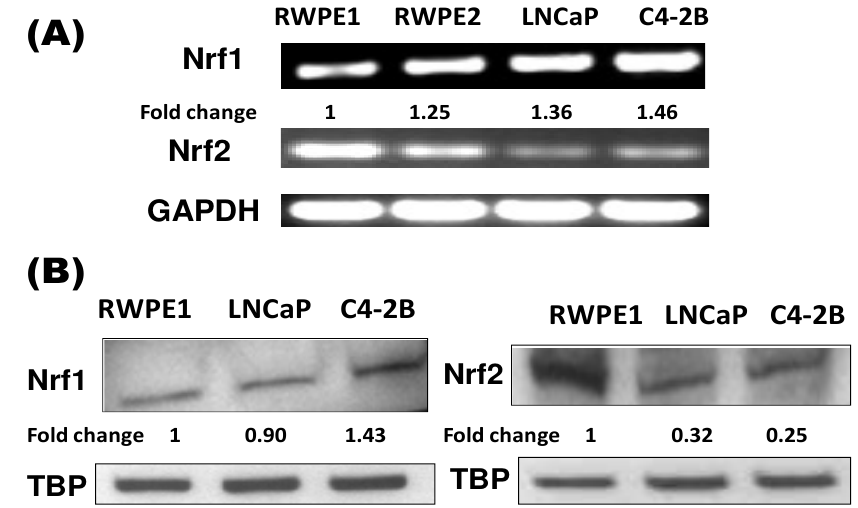
Figure 2. Nrf1 and Nrf2 Expression in Prostate Cancer Cell Lines. (A) RT-PCR for Nrf1 and Nrf2 mRNA expression in RWPE-1, RWPE-2, LNCaP, and C4-2B PCa cells are shown. GAPDH was used as the internal control (n = 3); (B) Nuclear Nrf1 and Nrf2 protein expression was measured in RWPE-1, LNCaP, and C4-2B PCa cells by western immunoblotting (n = 3). TATA Binding Protein (TBP) was used as internal control. Values are normalized to TBP and fold changes were calculated as compared to RWPE-1